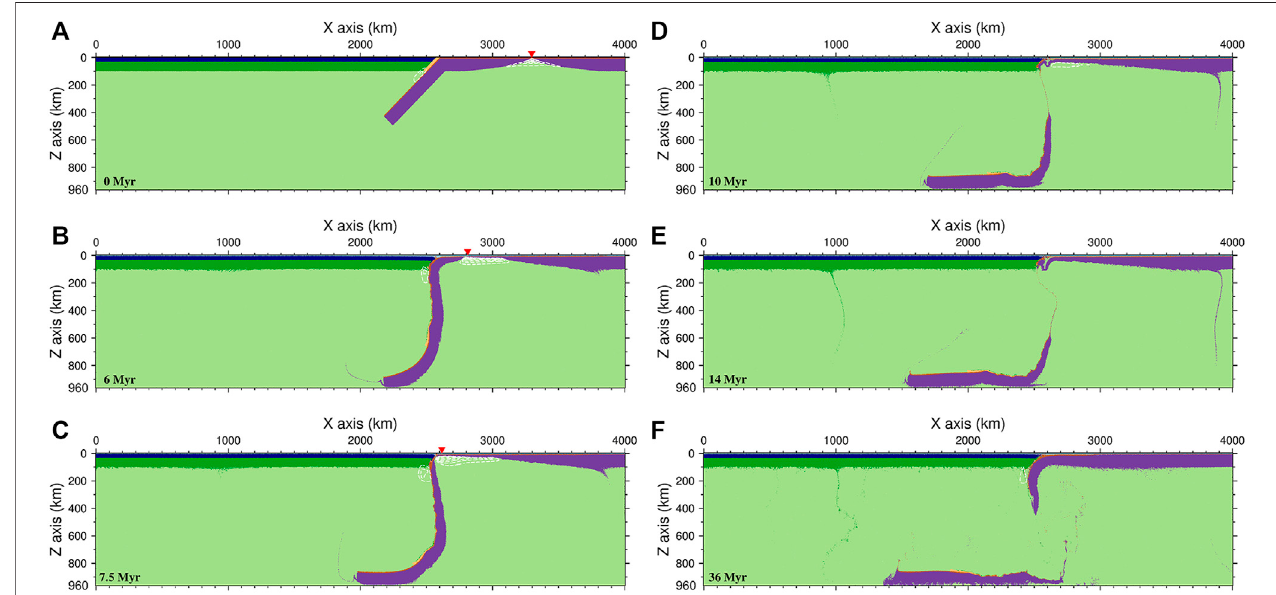
FIGURE 3| Model evolution ofcase RS01 ( L (cid:1) 600 km, V x (cid:1) 3 cm/yr, θ (cid:1) 45 ° ) with the ViscT viscosity structure. (A – F) Snapshotsat 0, 6, 7.5, 10, 14and 36 Myrs. The white dashed line represents the extent of melting with an interval of 5%. The red inverted triangle represents the location of the MOR.